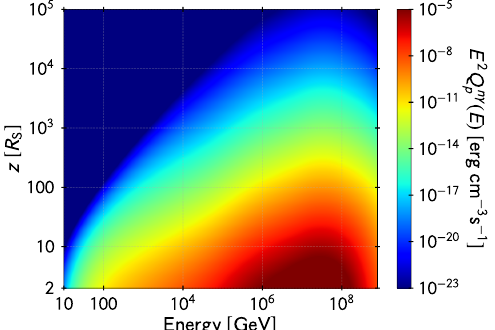
Figure 8. Proton injection in the jet axis via photo-hadronic collisions of neutrons in the funnel. The vertical axis is the distance to the hole in units of Schwarzschild radii and the horizontal axis is the energy of the created proton. The color map represents the energy density in protons injected per unit logarithmic bin of proton energy per unit time.